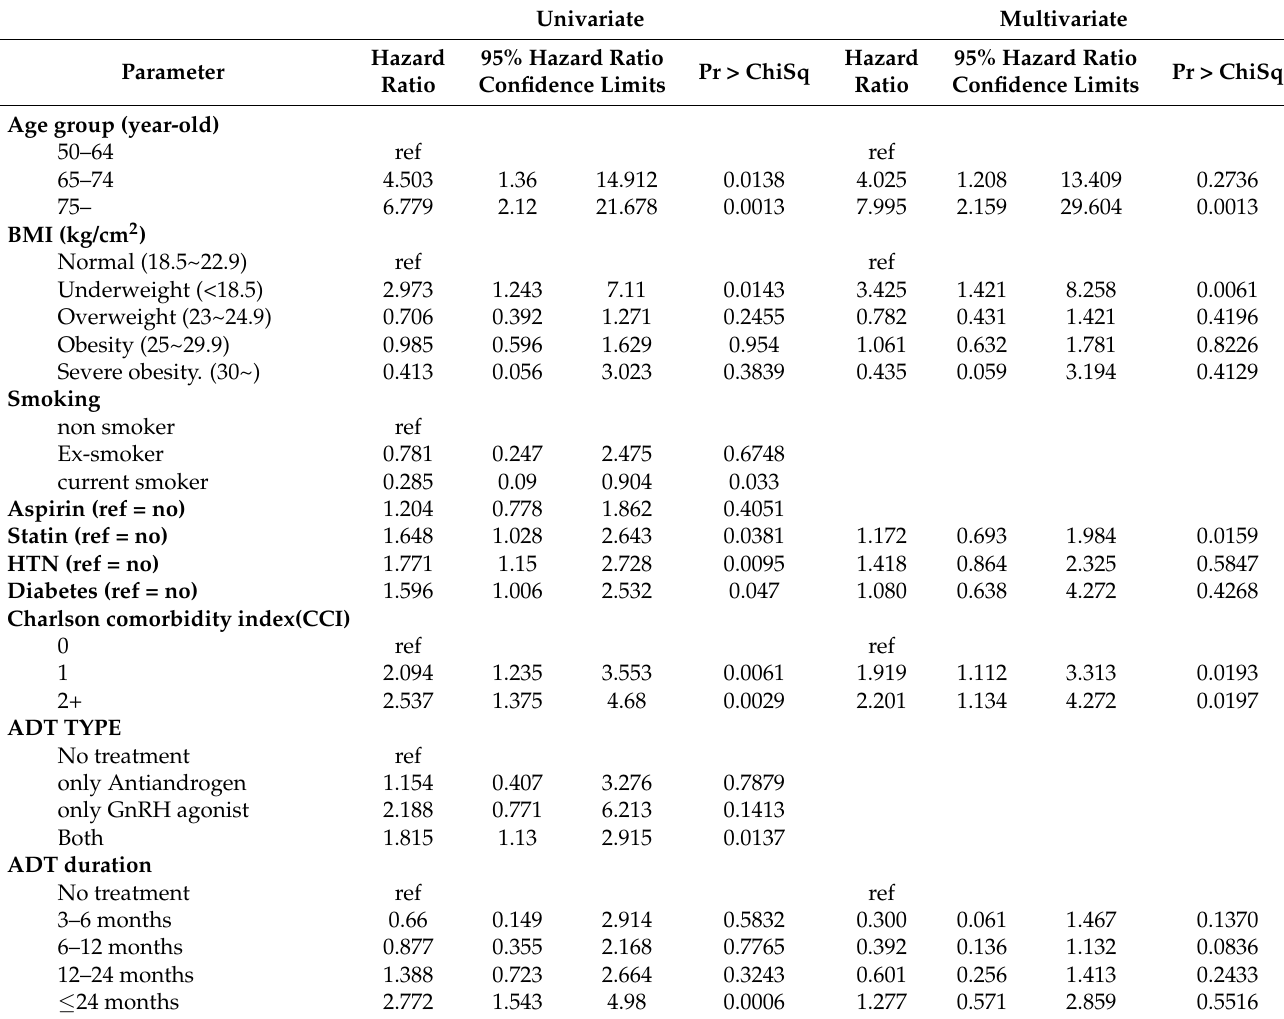
Table 5. Multivariate cox regression of risk factors for dementia among distant/unknown SEER staging patients after propensity-score